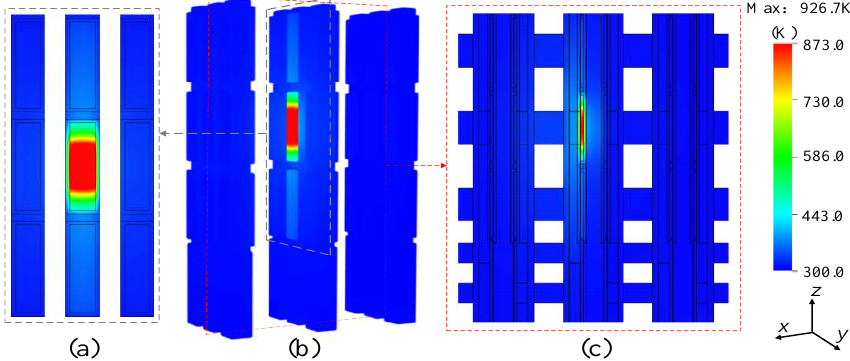
Figure 10. Temperature distributions of a PCM array composed of a diploid unit with 𝑤 GST = 12 nm : ( a ) cross-section in yz -plane; ( b ) 3-D structure; ( c ) cross-section in zx -plane.